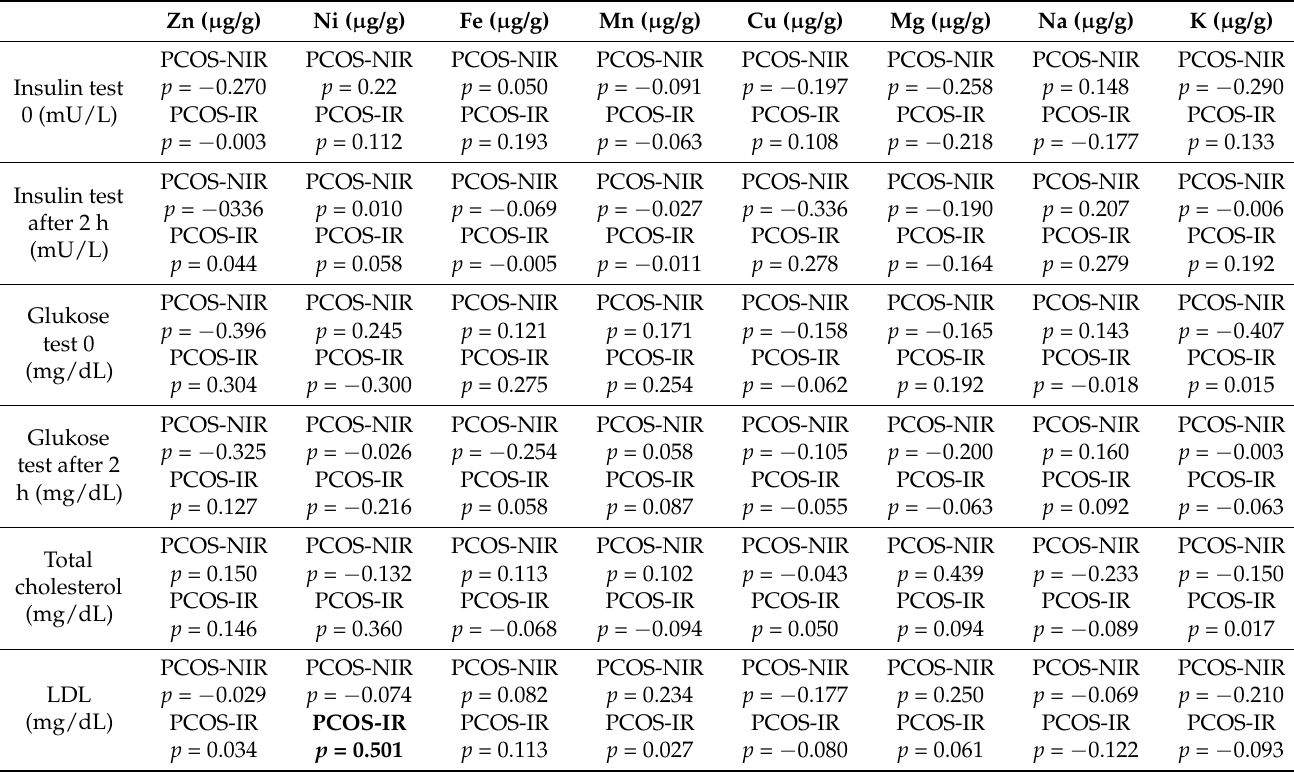
Table 5. Correlations of mineral composition with parameters of glycemic markers and lipid metabolism, taking into account the presence of insulin